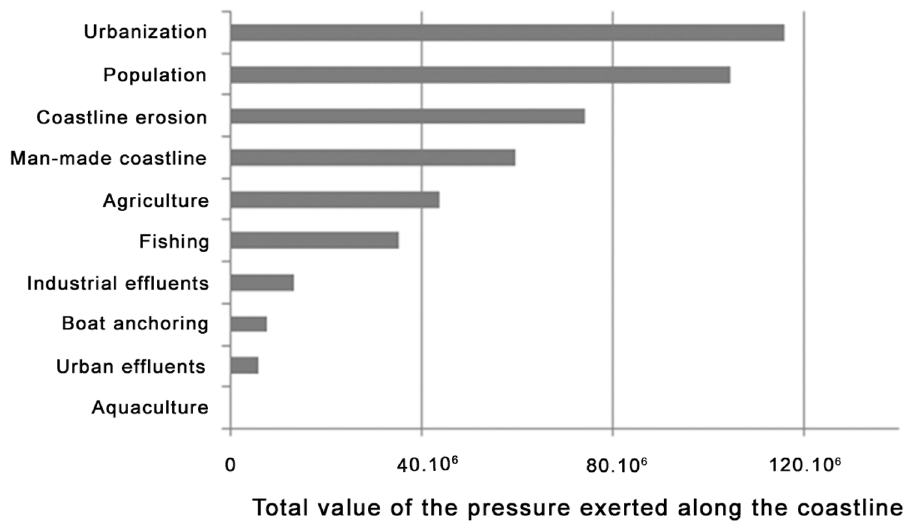
Fig 1. Total cumulated value (sum of all 20 x 20 m cell values concerning a pressure) of each individual pressure (no unit).